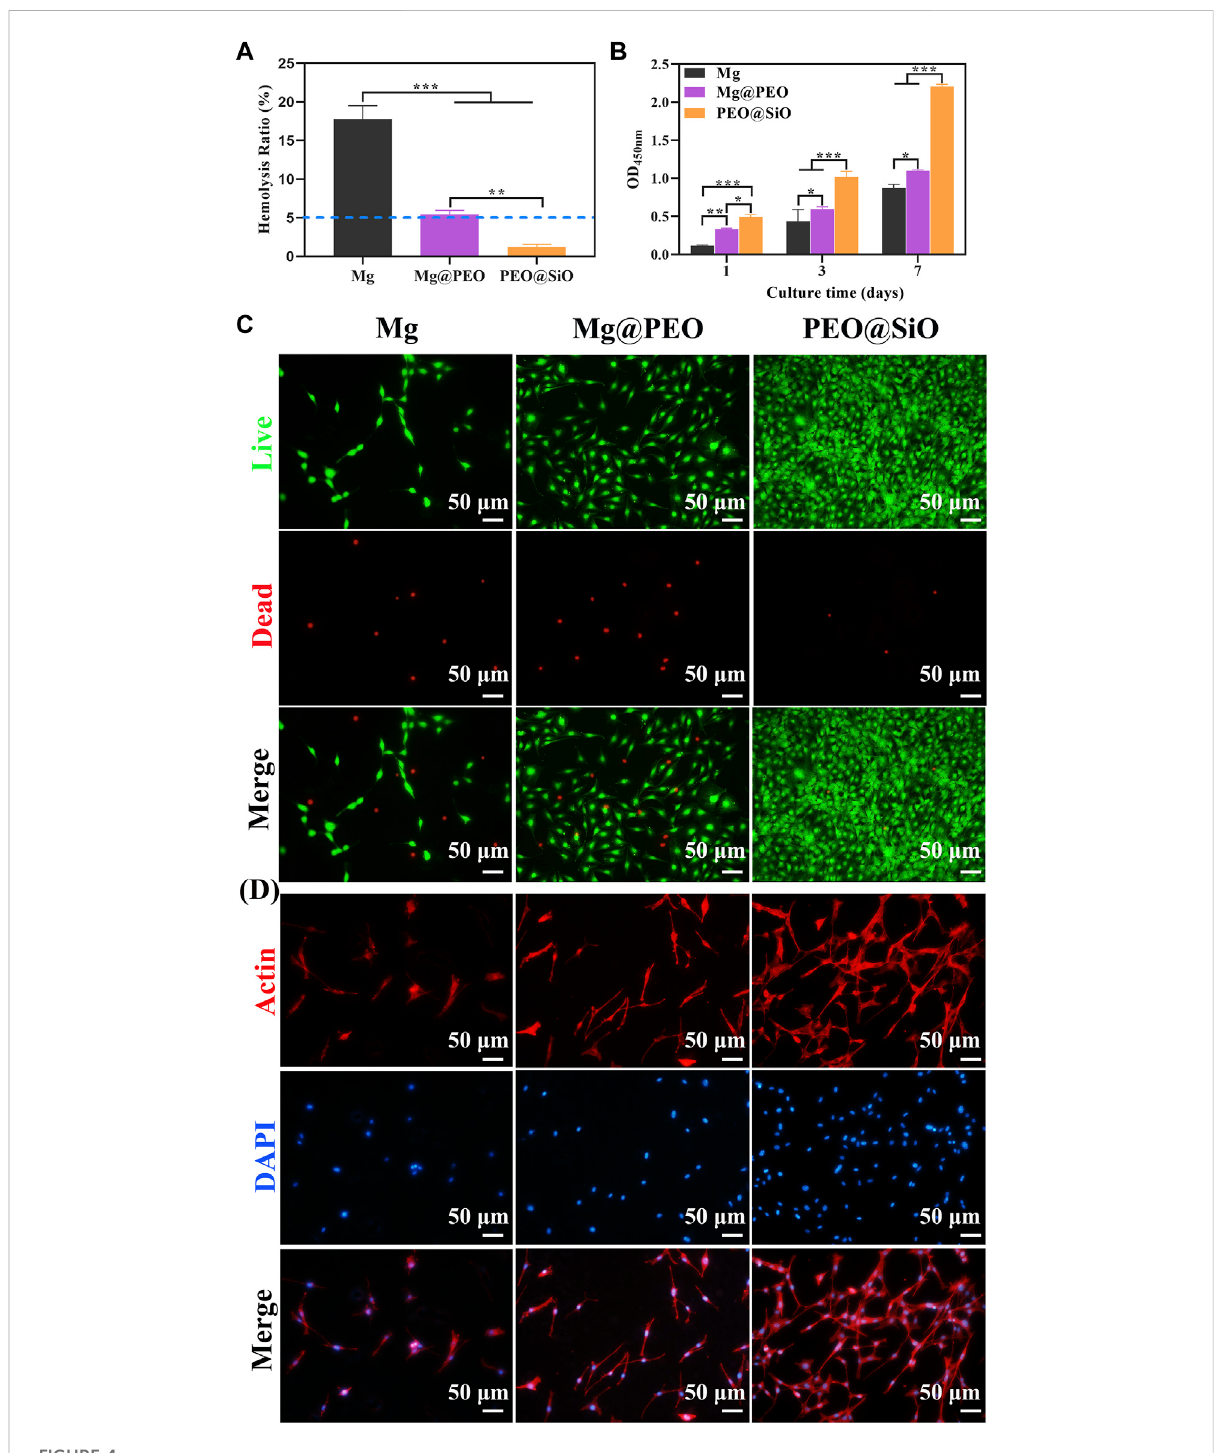
FIGURE 4 In vitro evaluation of biocompatibility: (A) Hemolysis rate (%) of Mg, Mg@PEO, and PEO@SiO samples. (B) Cell proliferation evaluated by CCK-8 assay for 1, 3, and 7 days. (C) Fluoroscopy images of live/dead (green/red) staining of MC3T3-E1 cultured on various samples for 1 day. (D) Fluoroscopy images of actin cytoskeleton stained with phalloidine (red) and the nucleus stained with DAPI (blue) of MC3T3-E1 cells cultured on various samples for 1